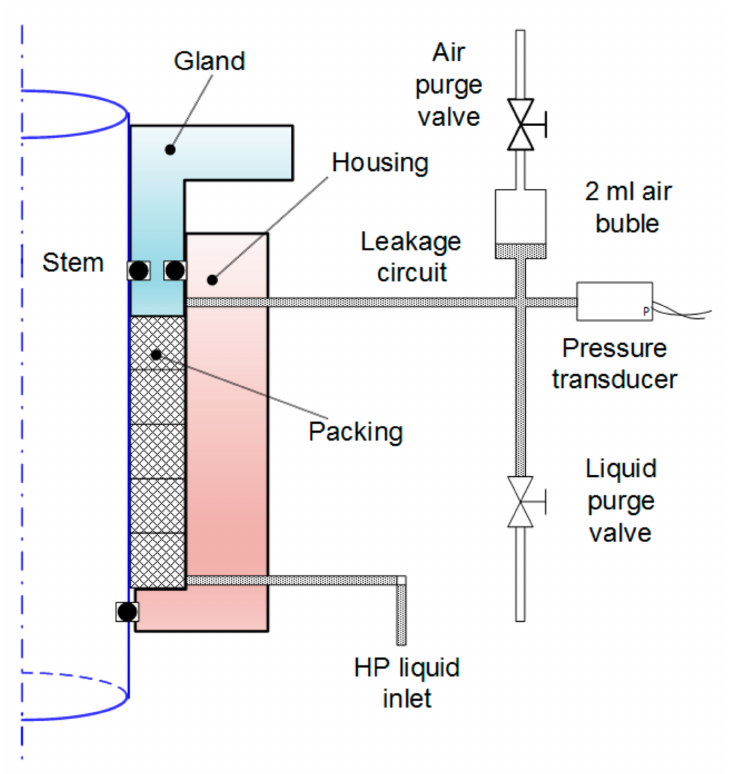
Figure 3. Liquid leak measuring device for packing